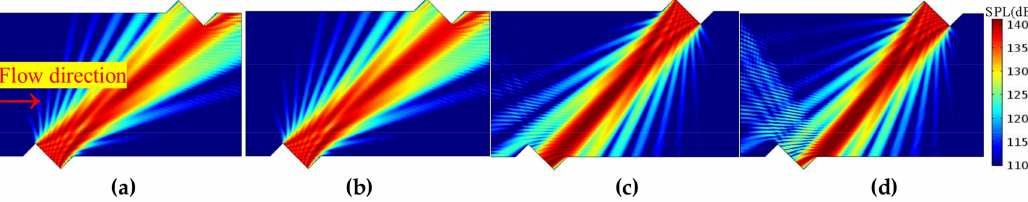
Figure 11. Acoustic beam for the T (i.e., turbulent) profile (flow direction is from left to right). ( a ) Downstream, v = 12.82 m/s. ( b ) Downstream, v =31.86 m/s. ( c ) Upstream, v = 12.82 m/s. ( d ) Upstream, v = 31.86 m/s.